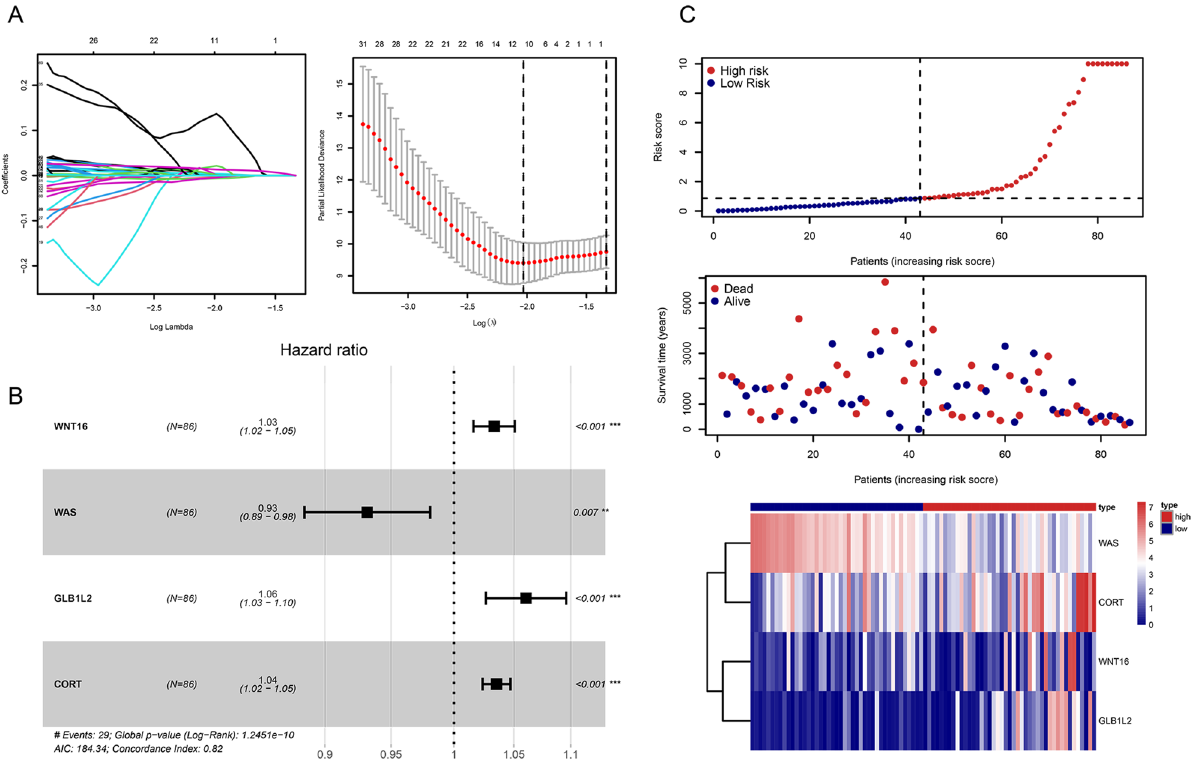
Figure 4. Determination of prognostic ferroptosis- and immune-related genes. ( A ) 100-fold cross-validation for choosing tuning parameters of the Least Absolute Shrinkage and Selection Operator (LASSO) model. The LASSO coefficient profiles of prognostic genes. ( B ) Prognosis-related genes screened further using a stepwise Cox proportional hazards regression model. ( C ) Distribution of the risk score and gene expression profile. The risk factor heatmap shows expression abundance of four hub genes in the high-low riskscore